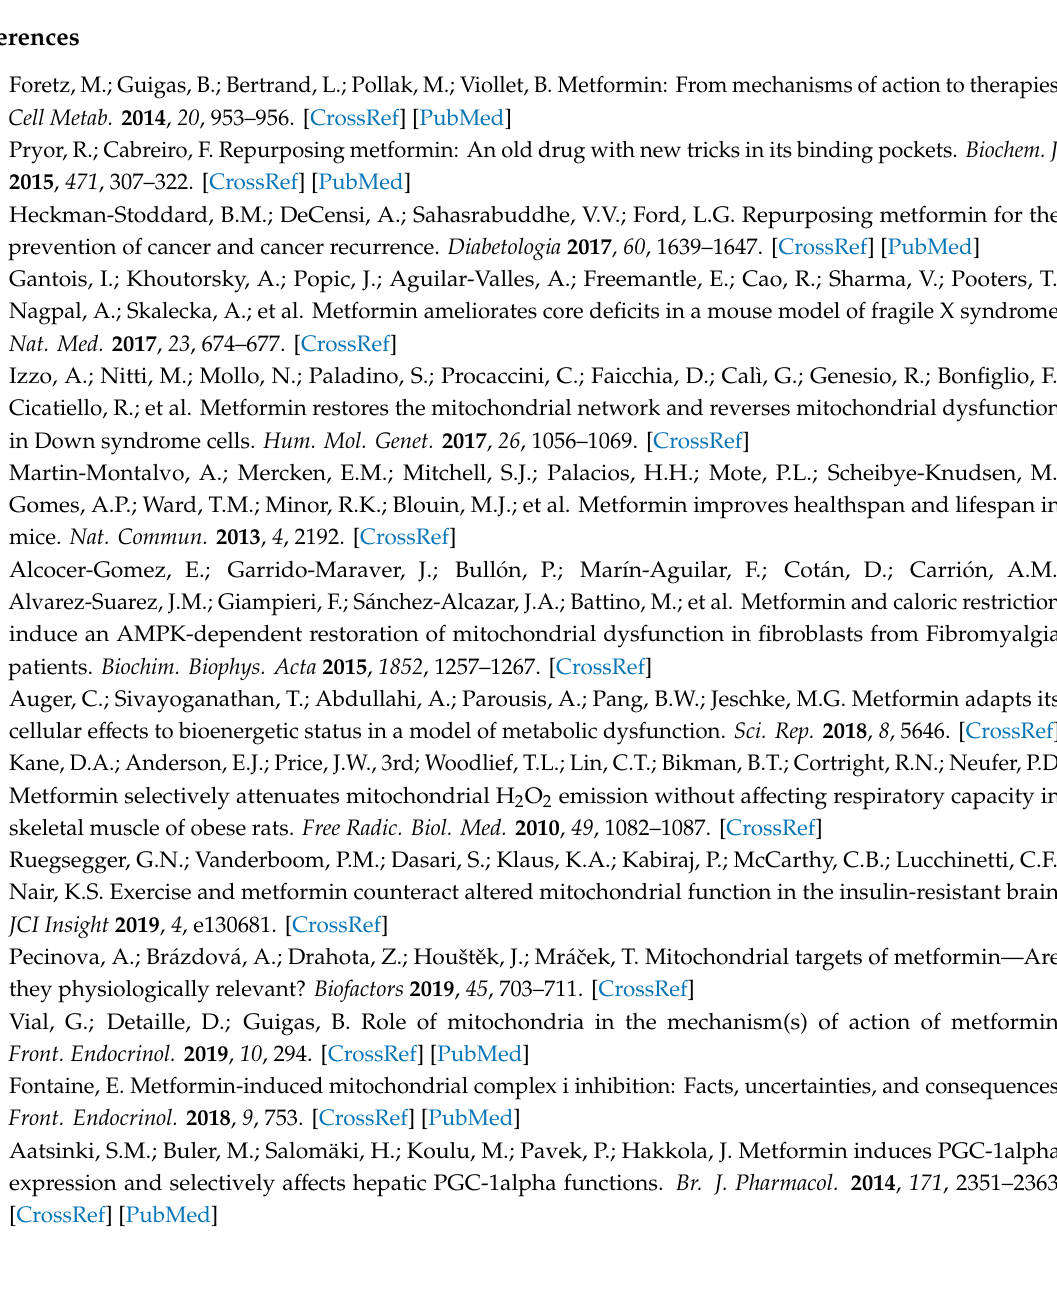
Table S1: Summary of two-way ANOVA analyses and post hoc tests of all the results, Figure S1: Full Immunoblot of Western blot